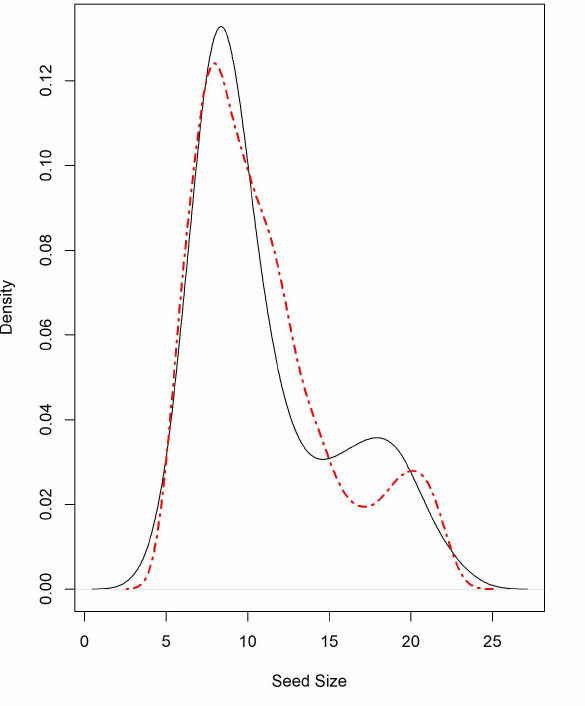
Figure 5. The plot of smoothed original density function (solid line) and reconstructed density function from 1856 simulated samples (dotted